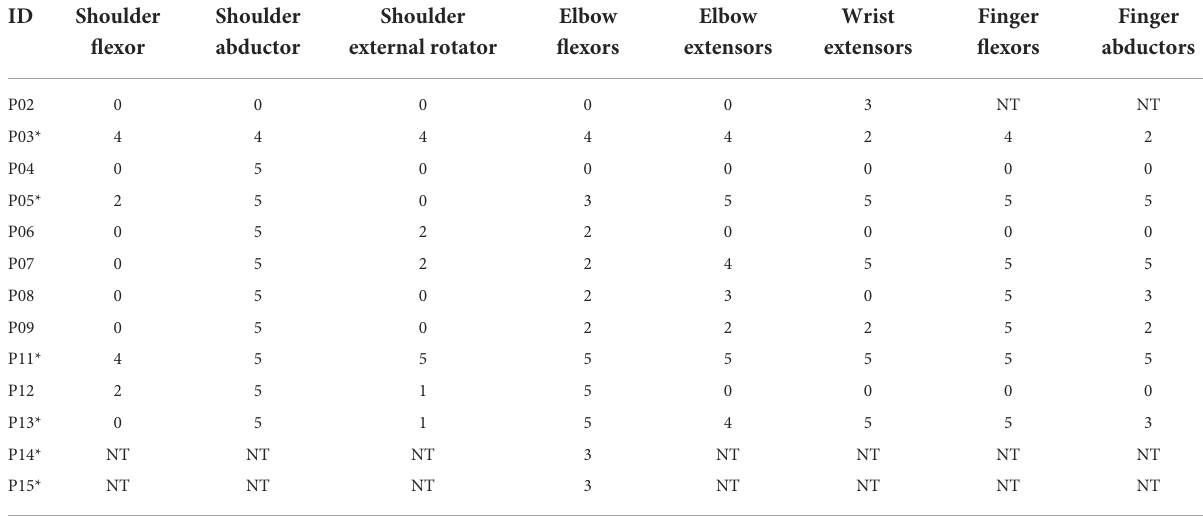
TABLE 2 TBPI patients’ evaluation of the injured UL muscle strength.